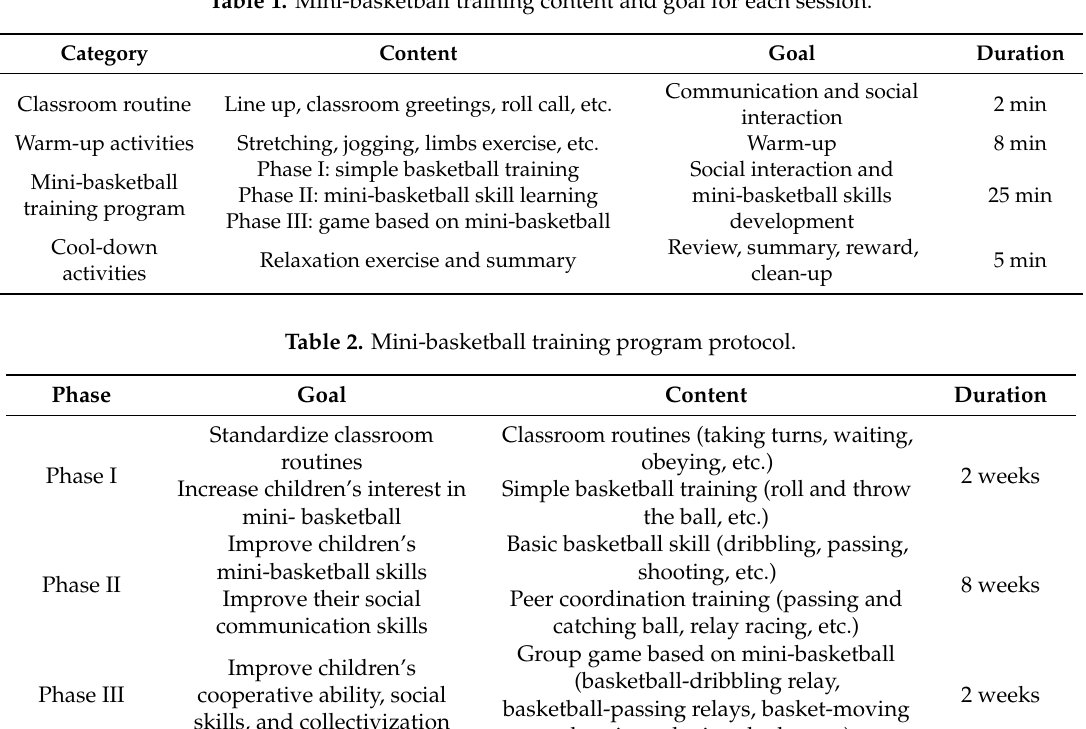
Table 1. Mini-basketball training content and goal for each session.